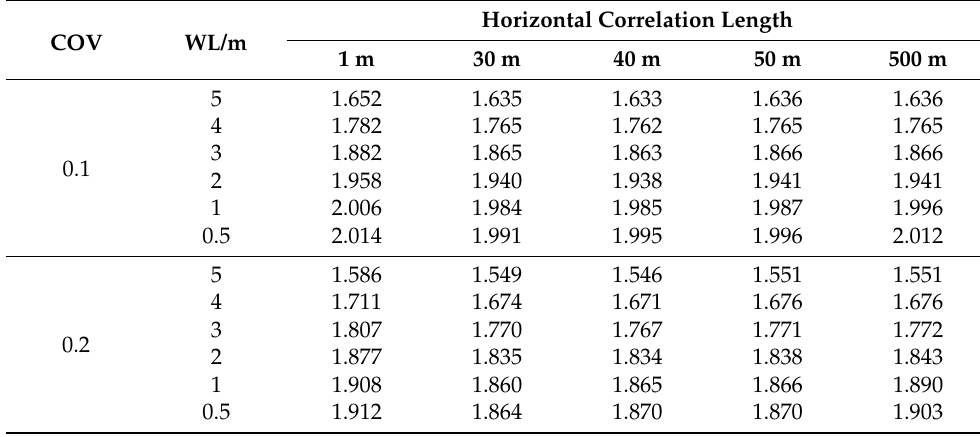
Table A1. The result of FOSs of random